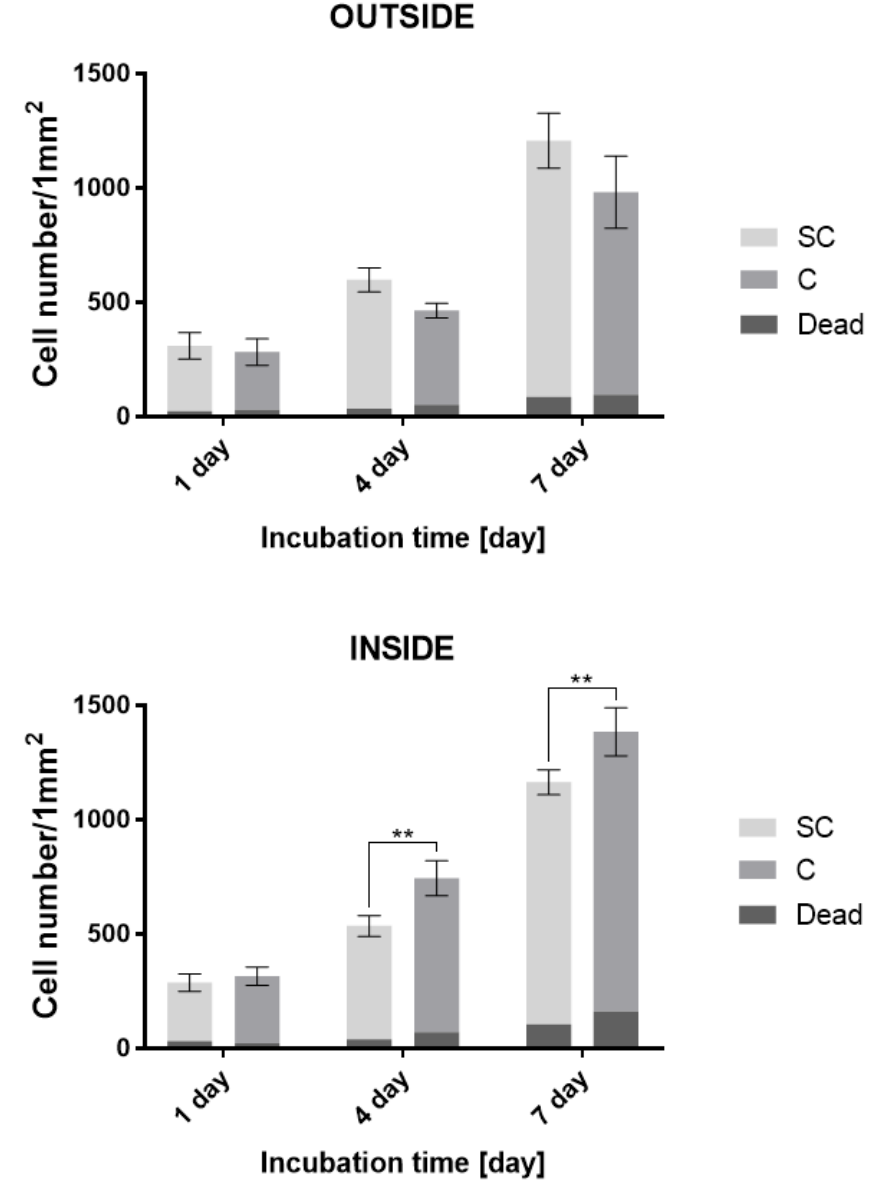
Figure 10. Cell proliferation rate described by cell number on 1 mm 2 —comparison of the effect of internal bioprinting of selected bioink and scaffold without bioink on the viability of human osteoblasts (mean value ± standard deviation, n = 10). Statistically significant difference in the significance level: ** p < 0.0046 (ANOVA, post-hoc Tuckey). The top section shows the number of cells per mm 2 on the surface. The bottom part shows the number of cells per mm 2 into the structure. C—Hydrogel with incorporated collagen, SC—scaffold with conventionally seeded cells, Dead—Number of dead